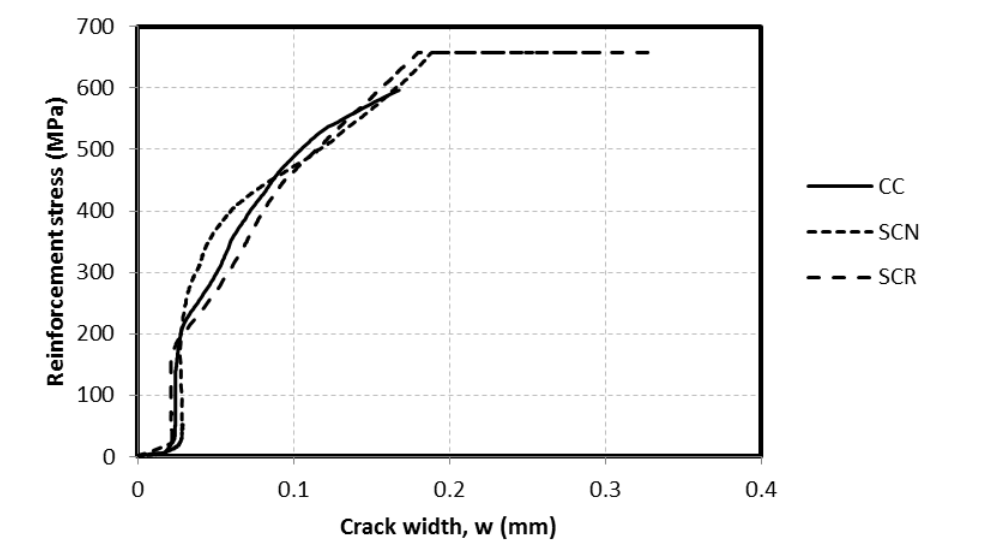
Figure 8. Reinforcement stresses vs. crack width.